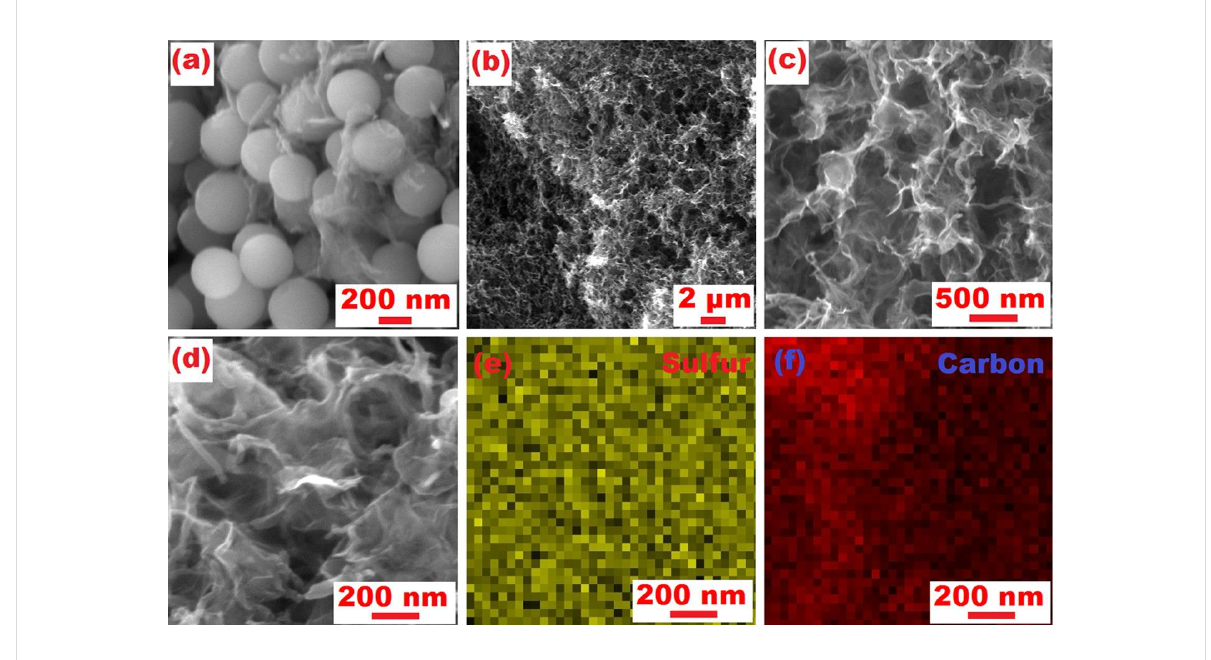
Figure 2: SEM images of (a) RGO@MWCNT@SiO 2 , (b, c) 3D-RGO@MWCNT at different magnifications and (d) S-3D-RGO@MWCNT, and corre- sponding elemental maps of (e) sulfur and (f) carbon.